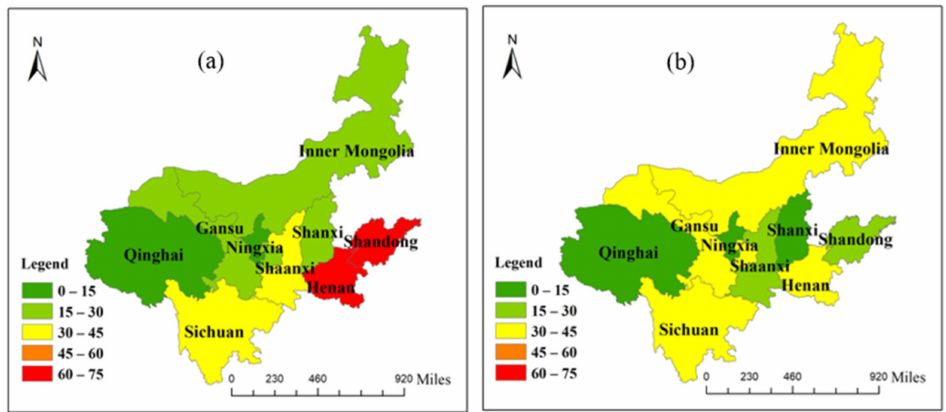
Figure 9. Virtual water trade of each province in the Yellow River Basin: ( a ) the total outflow of virtual water; ( b ) the total inflow of virtual